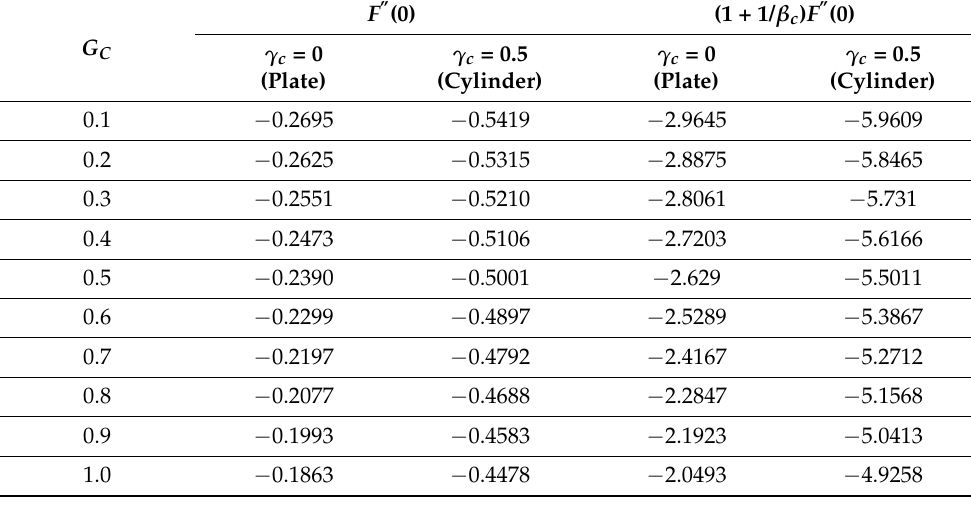
Table 7. Variation in SFC for β c .